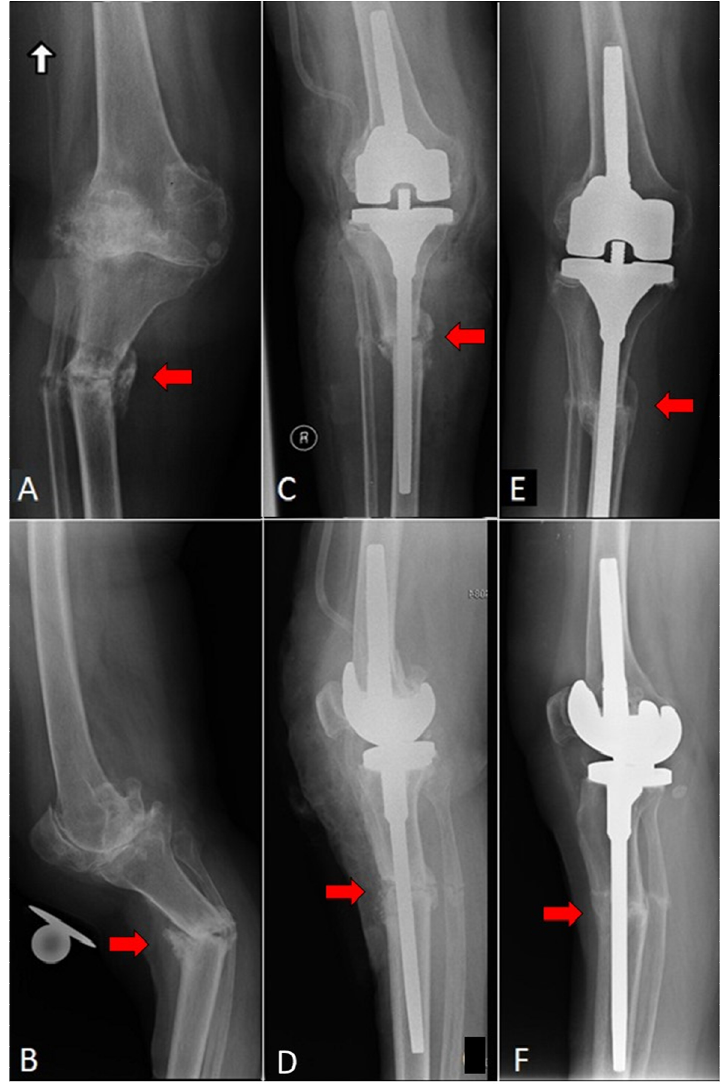
Figure 2. ( A ) AP and ( B ) lateral radiograph of the patient with 1/3 proximal tibial and fibular shaft fractures (pseudarthrosis) and coexisting severe knee osteoarthritis. Early postoperative radiographs ( C ) AP and ( D ) lateral (Scorpio TS, Stryker, Mahwah, NJ, USA). CCK knee implant with long tibial stem was used. ( E ) AP and ( F ) lateral radiographs of the knee performed. Table 1. Type of implant used in the study groups.